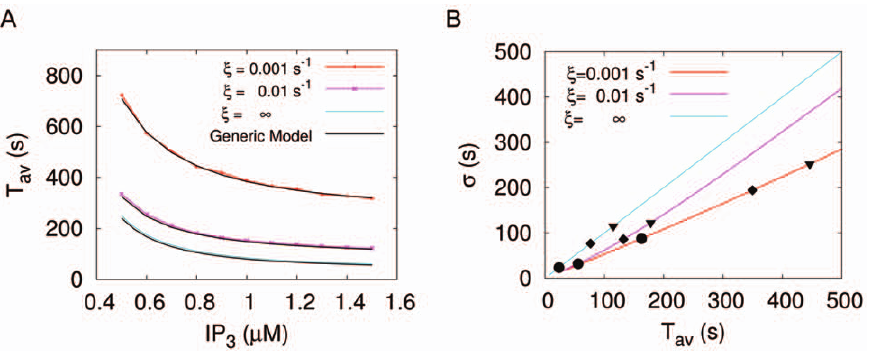
Figure 6. The generic model is a valid approximation of the hierarchic stochastic model and provides s – T av relations close to experimental data. (A) Comparison of numeric results for the tetrahedron model with the results for T av of the generic model with different feedback strengths represented by j (see also S1). For j ? ? , the model approaches the analytically treatable case, where the slope of the relation equals one. (B) s – T av relation of the generic model. To demonstrate the impact of the coupling strength C 14 , we added the individual values of T av for three different values of C 14 (0.05, 0.01, 0.008) to each line. Modification of the coupling strength merely leads to a shift of the cell along the s – T av relation and does not affect the slope of the relation.